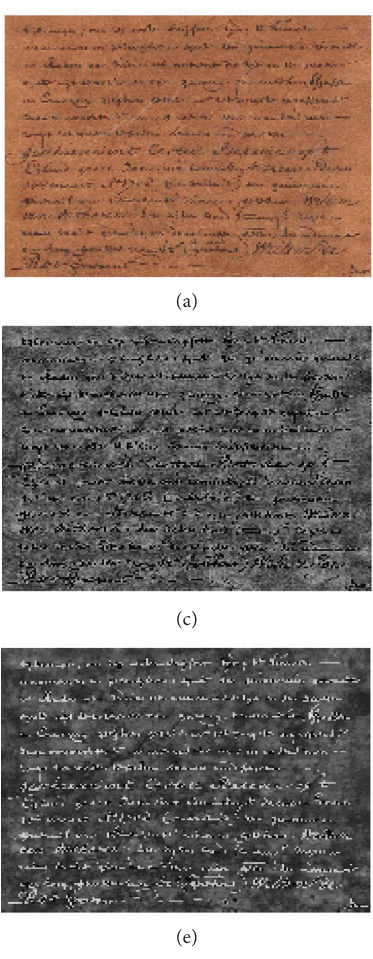
l cluster. (c) C 2 cluster. (d) C 3 cluster.